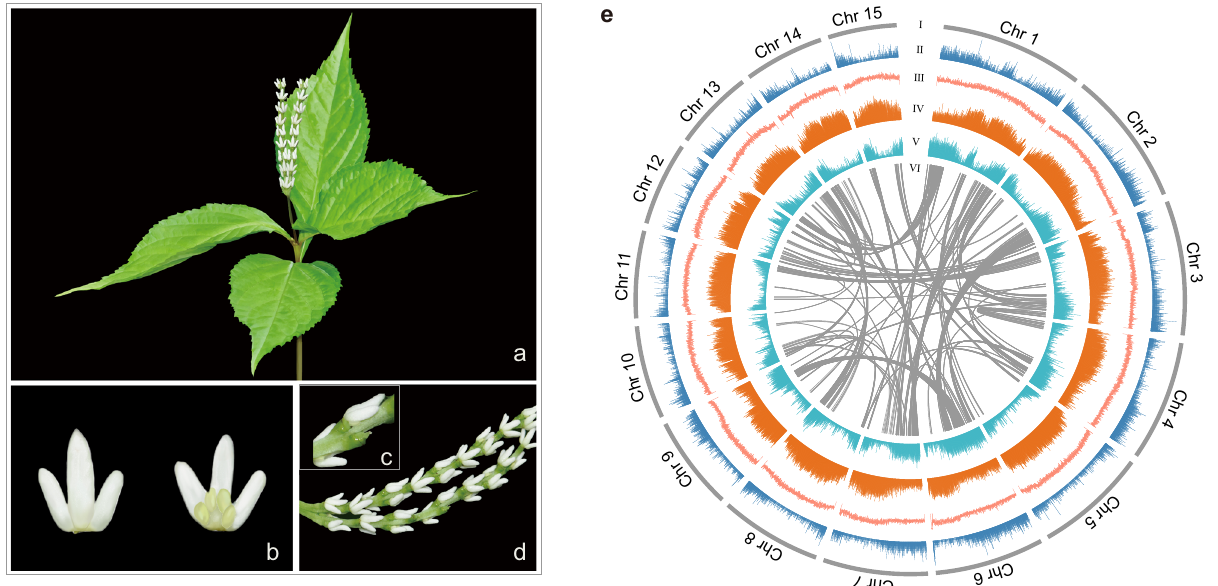
Fig. 1 C. sessilifolius morphology and genome features. a Habit of C. sessilifolius . b Stamen. c Pistil. d In fl orescence. e Overview of C. sessilifolius genome. Different tracks (moving inward) denote (I) chromosomes; (II) gene density in 100 kb sliding windows (minimum – maximum, 0 – 30); (III) GC content in 500 bp sliding windows (minimum – maximum, 0.2 – 0.8); (IV) Gypsy density in 10 kb sliding windows (minimum – maximum, 0 – 1.0); (V) Copia density in 10 kb sliding windows (minimum – maximum, 0 – 1.0); (VI) identi fi ed syntenic blocks. Source data are provided as a Source Data fi